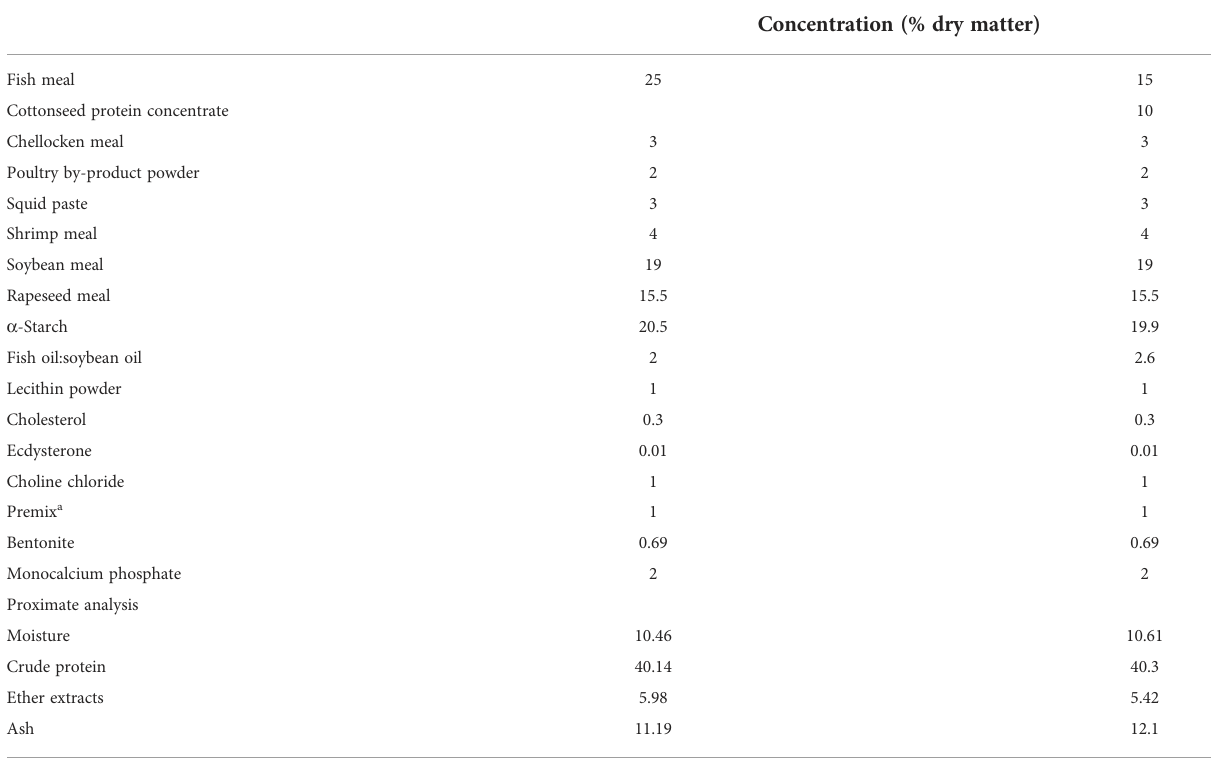
TABLE 1 Ingredients and proximate analysis of HF diets and LF